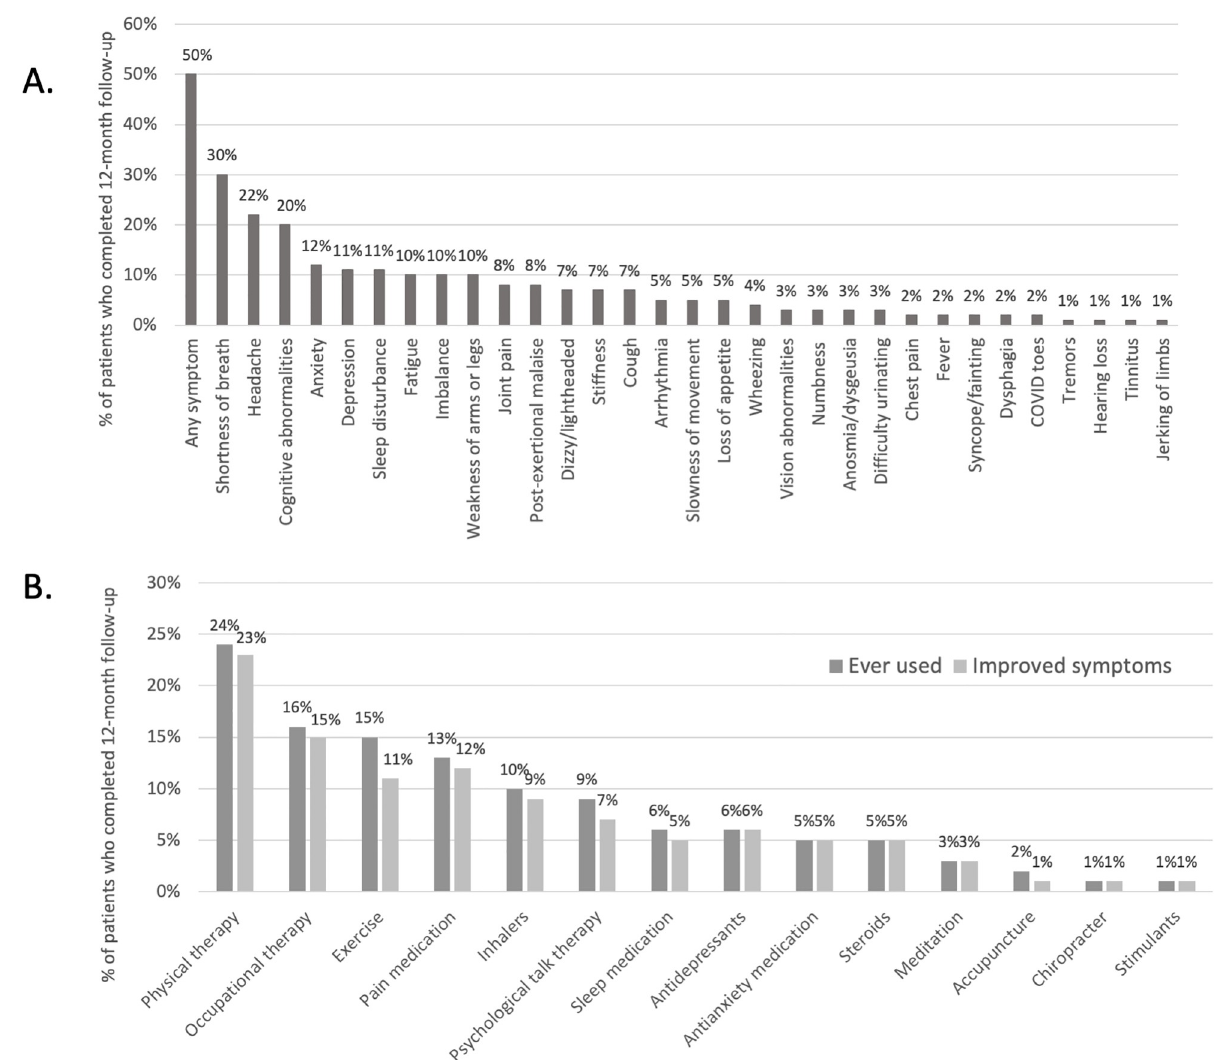
Fig 1. Frequency of PASC symptoms, therapies received and rates of response to therapy. A. Frequency of post-COVID symptoms lasting � 4 weeks after initial diagnosis as reported by participants 12-months after hospitalization for COVID-19 (N = 242). B. Percent of patients who received, and responded to a given therapy for PASC symptoms within 12-months after hospitalization for COVID-19 (N = 242).